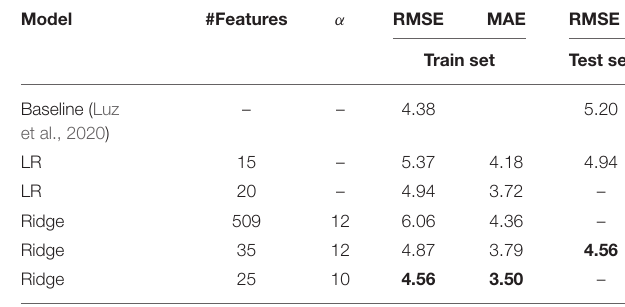
TABLE 9 | LOSO-CV MMSE regression results on the ADReSS train and test sets.